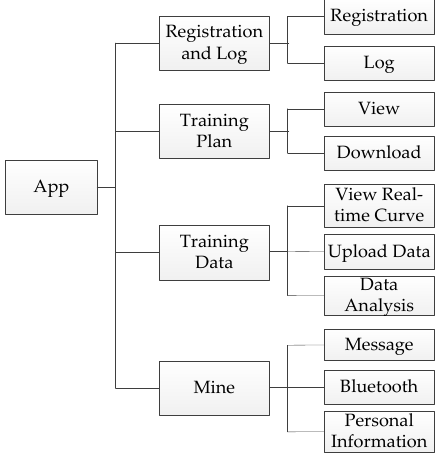
Figure 3. Functional block diagram.